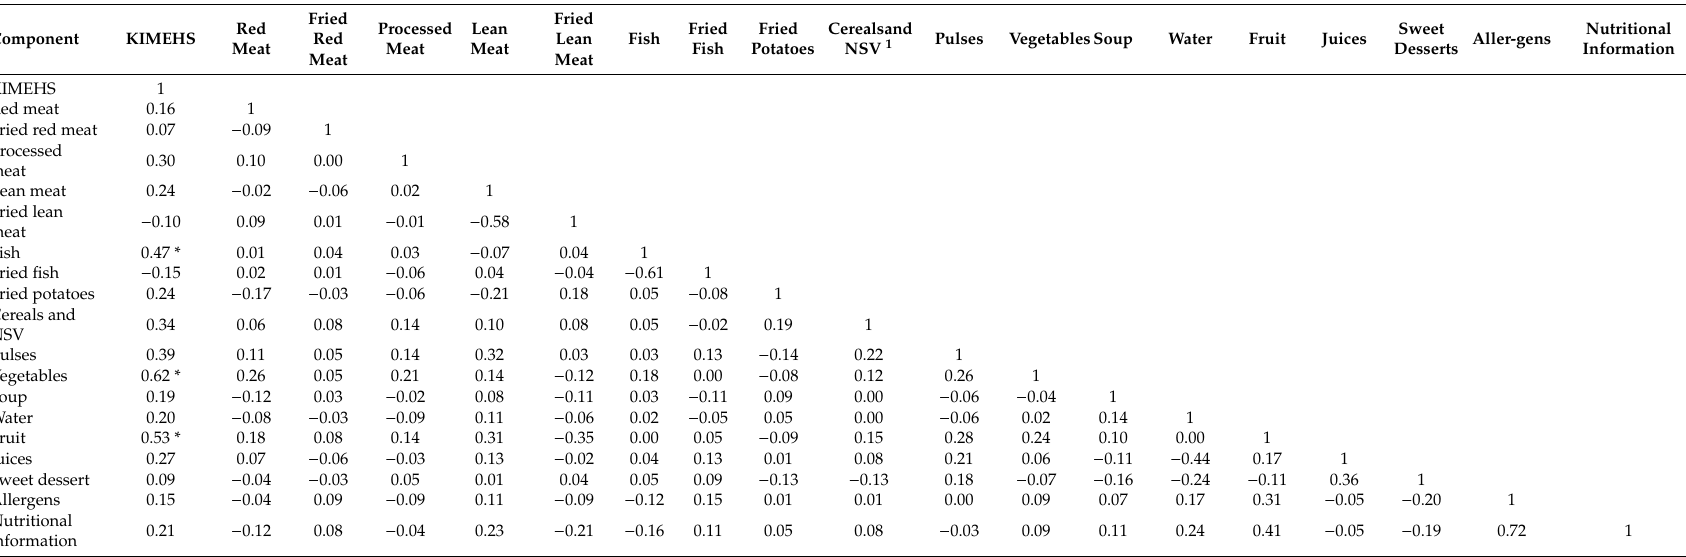
Table 4. Correlations of the KIMEHS